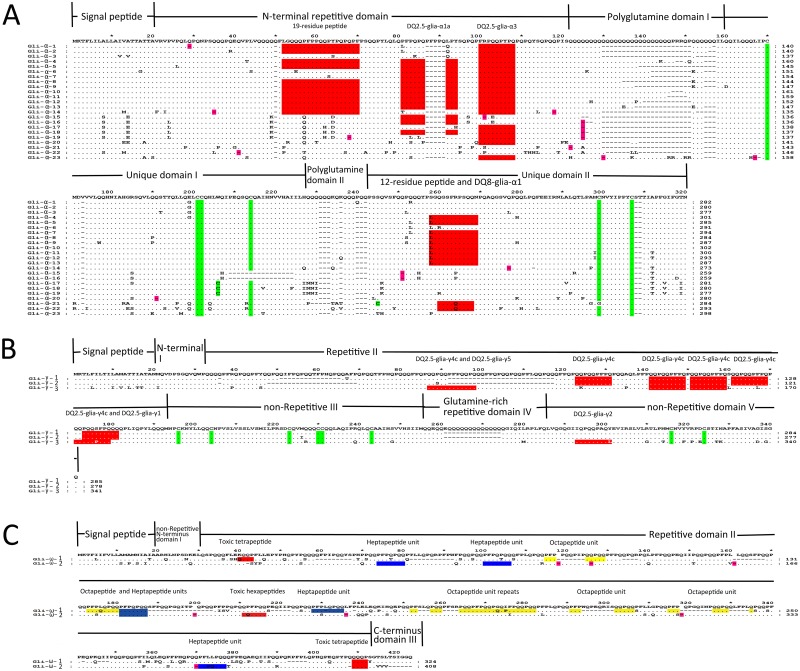
Multiple alignment of the predicted amino acid sequences of the gliadin genes from T. urartu.(A) Protein sequence alignment of the 23 α-gliadin genes. (B) Protein sequence alignment of the three γ-gliadin genes. (C) Protein sequence alignment of the two ω-gliadin genes. The stop codons are indicated by dashes with a pink background, and deletions are dashes without any background. The cysteine residues and toxic epitopes in each type of gliadin were highlighted by green and red backgrounds, respectively. The heptapeptide units in the ω-gliadins have a blue background, and the octapeptide units have a yellow background.